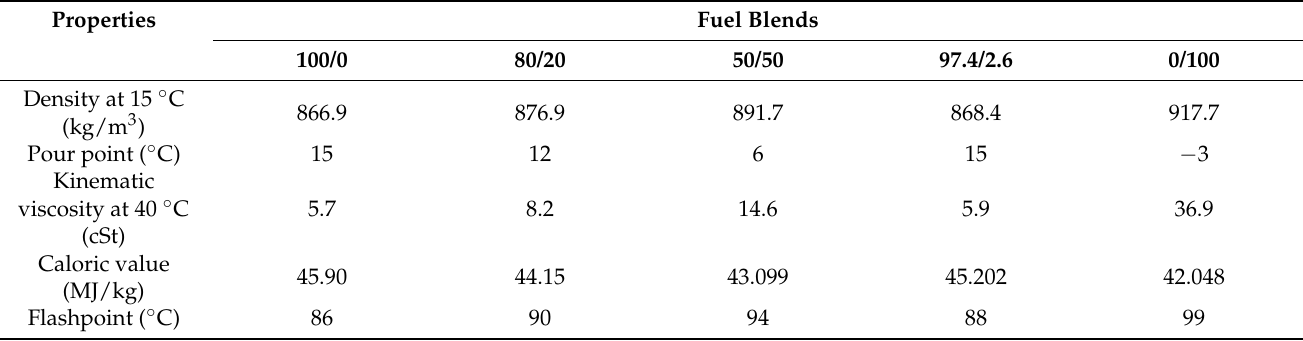
Table 7. Physico-chemical characteristics of JCL fuel and its blends compared to diesel